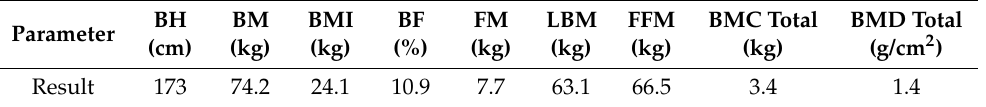
Table 1. Anthropometrics and body composition status.